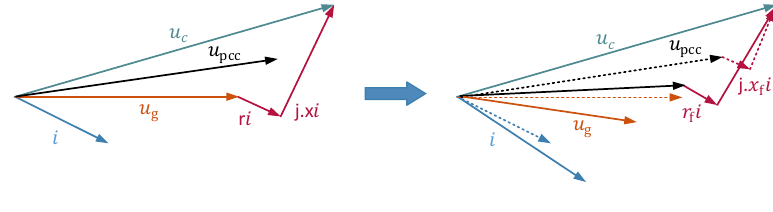
Figure 11. Phasor diagram after fault occurrence in the grid.